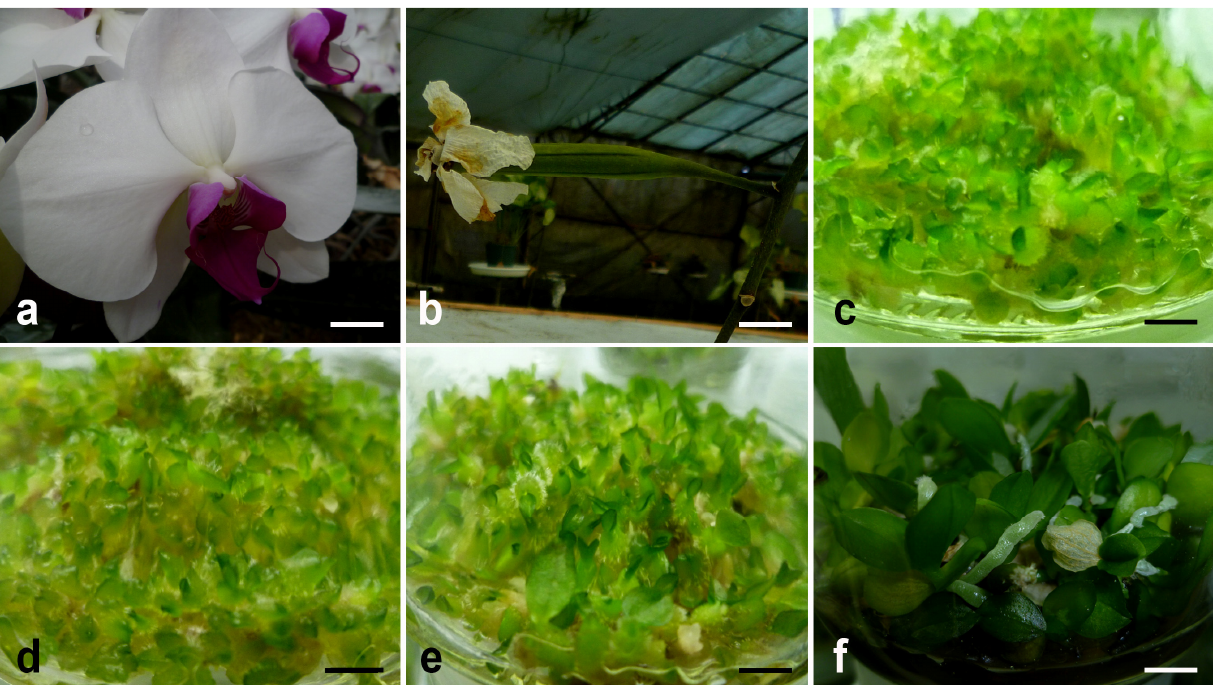
Fig. 1. Pollination, post-pollination capsule formation and asymbiotic seed germination in Phalaenopsis cv. ‘Dublin’; a) pollinated flower, b) post-pollination development of capsule, c ) seed germination on Chen medium, d) seed germination on Vacin-Went medium, e) seed germination on ½MS medium, f) in vitro rooting of germinated plantlets on ½MS with 2.5 g/l activated